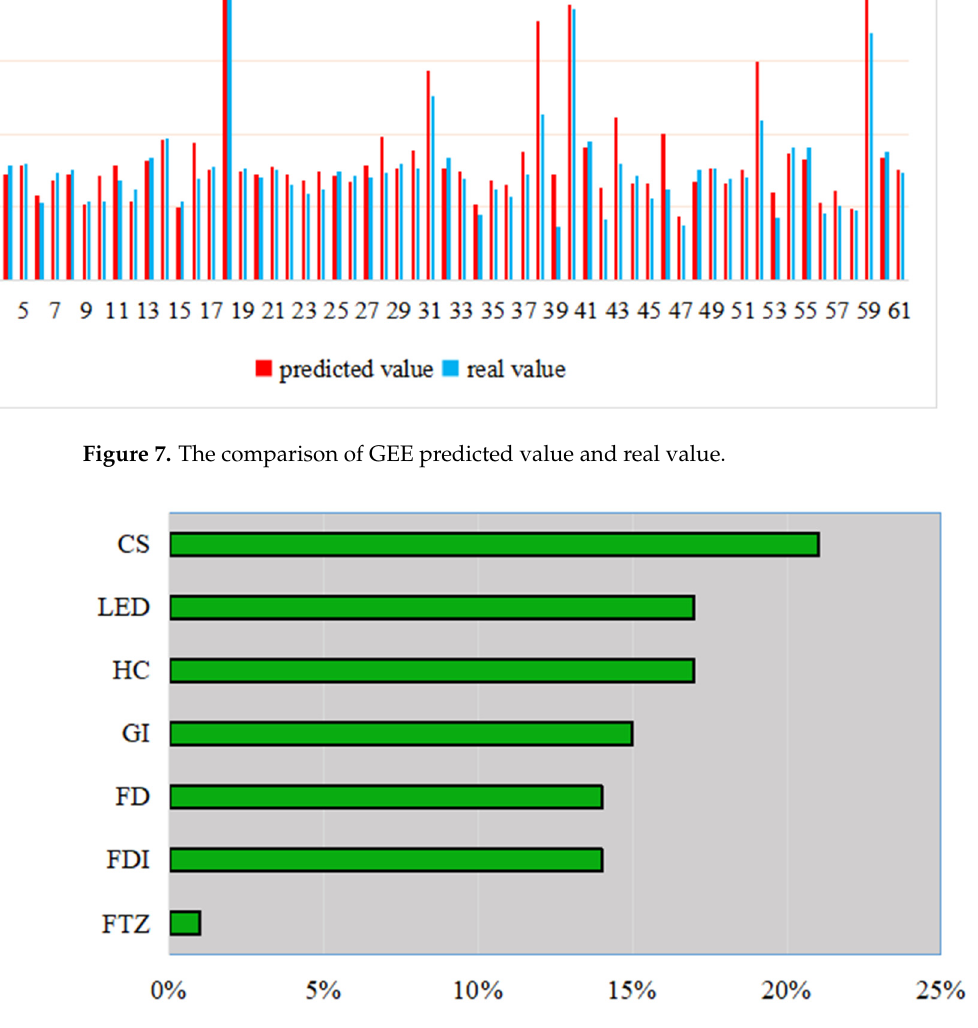
Figure 8. The contribution for determinants of GEE